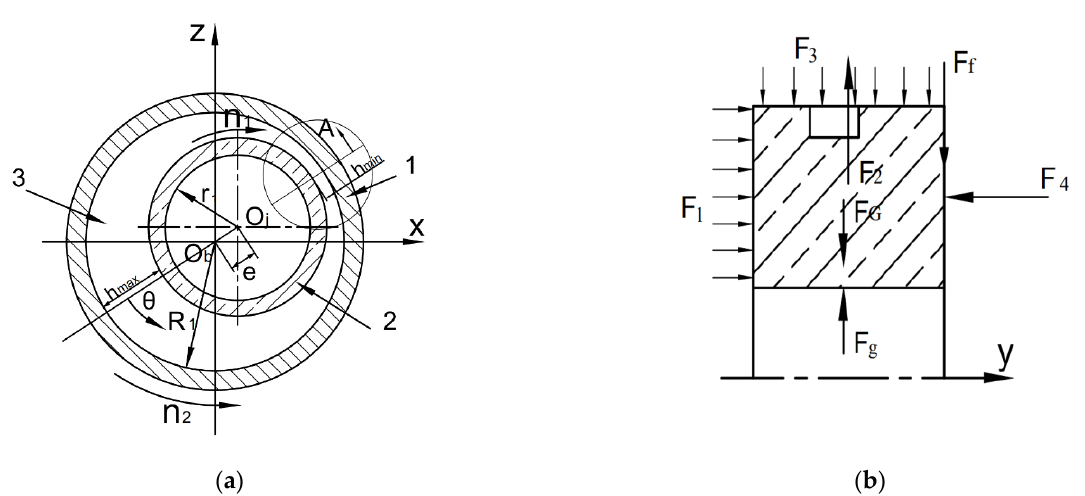
Figure 2. Schematic diagram for the sealing ring, including: ( a ) circumferential movement: 1 — Sealing ring, 2 — Inner rotor, 3 — Gas; ( b ) axial section force.